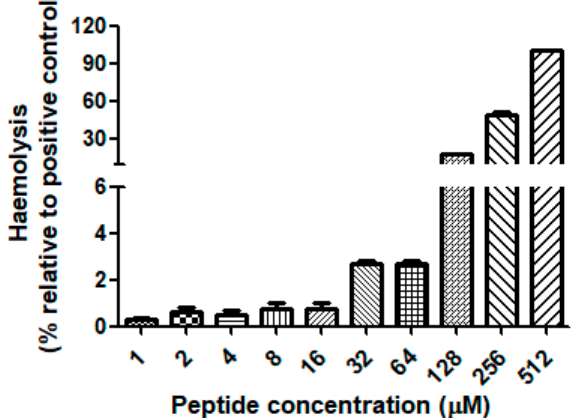
Figure 8. The haemolytic activity of Dermaseptin-PH was tested on horse red blood cells. The positive control group was treated with 1% Triton X-100 lysis buffer.